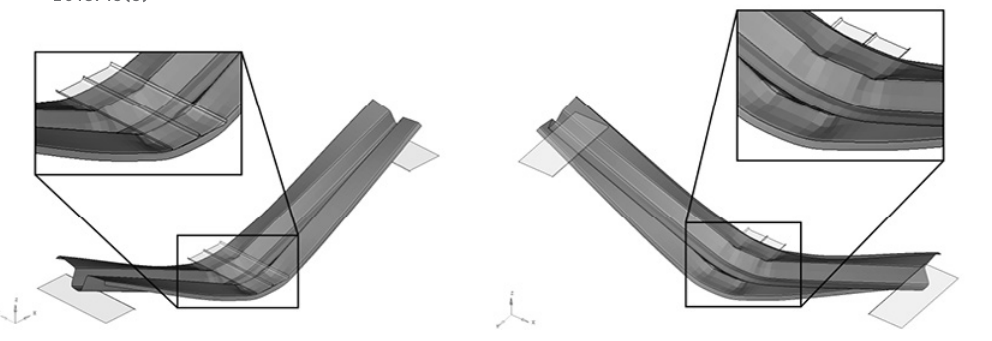
Figure 10. Final deformation of guide rail B